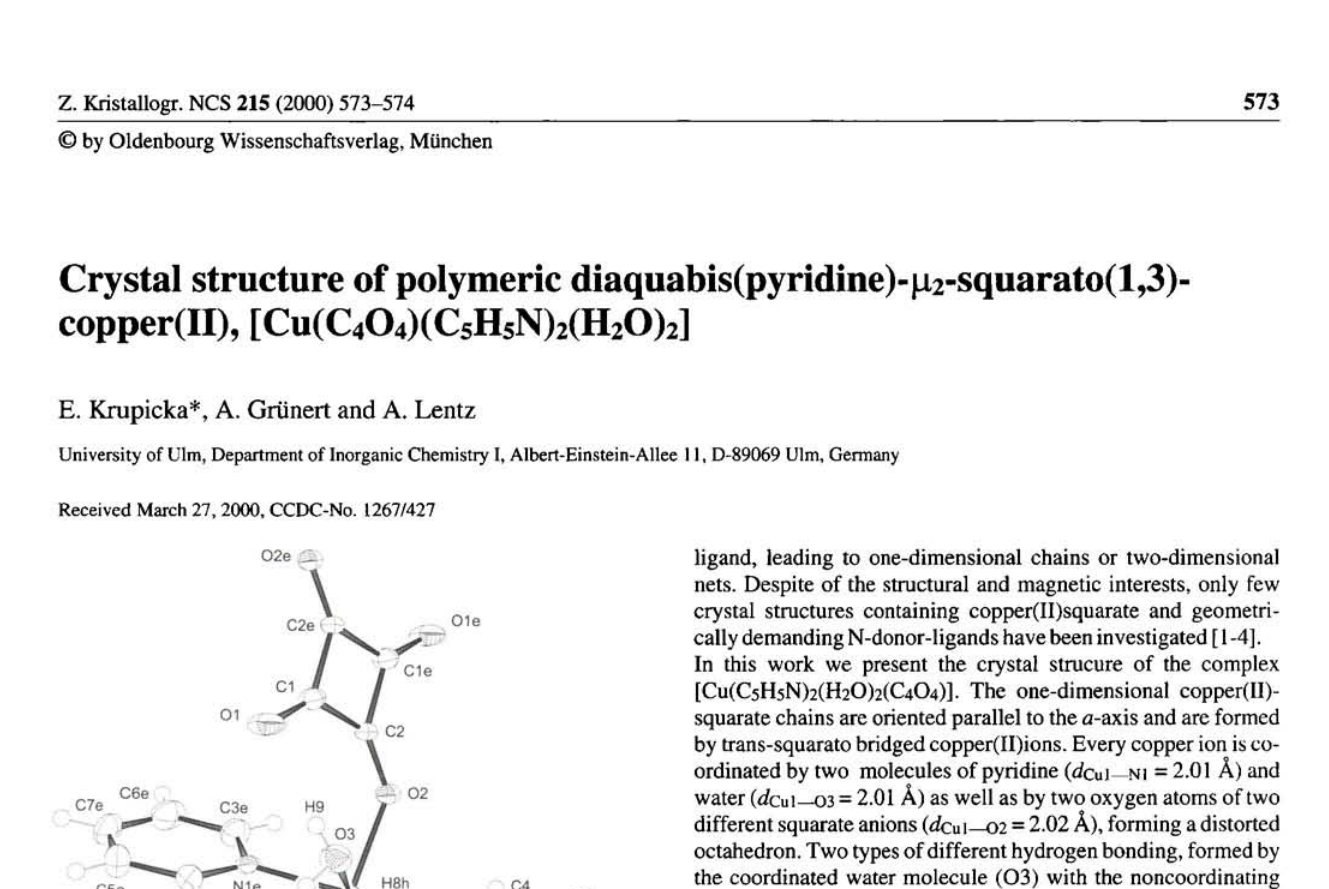
Table 1. Data collection and handling.